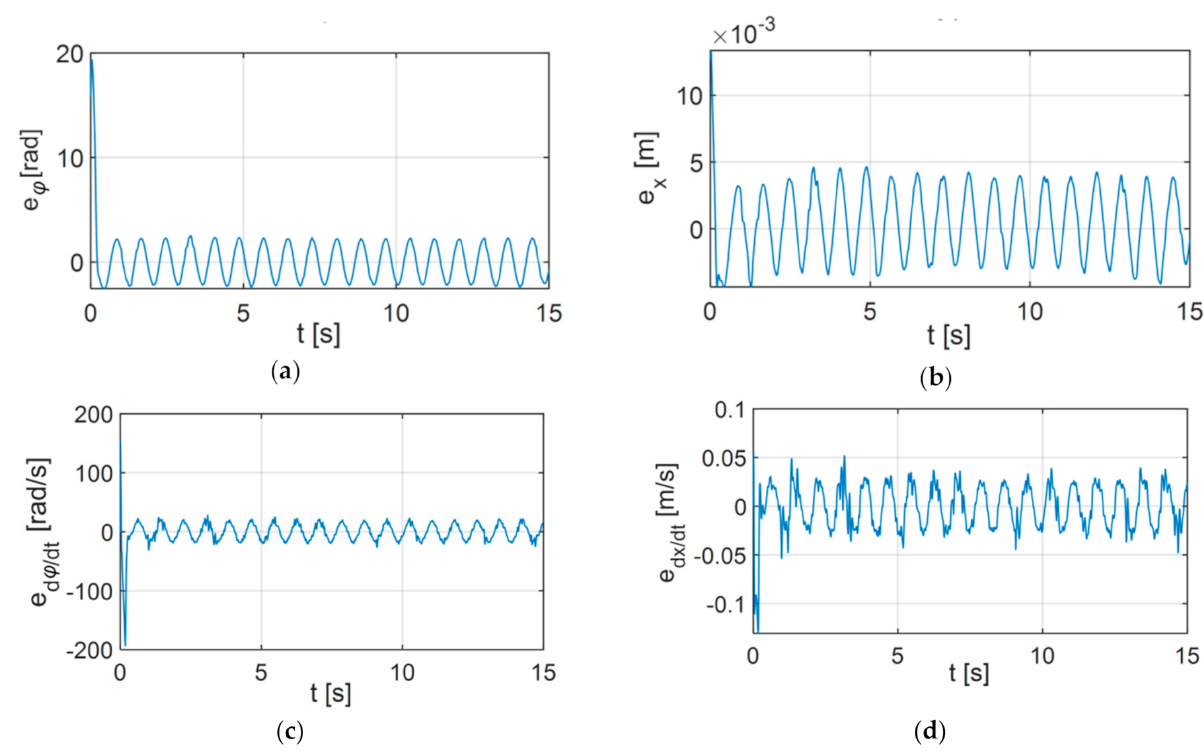
Figure 21. Follow-up movement errors: ( a ) position error of the active part e ϕ ; ( b ) position error of the passive part e x ; ( c ) speed error of the active part e d ϕ / dt ; ( d ) speed error of the passive part e dx / dt .